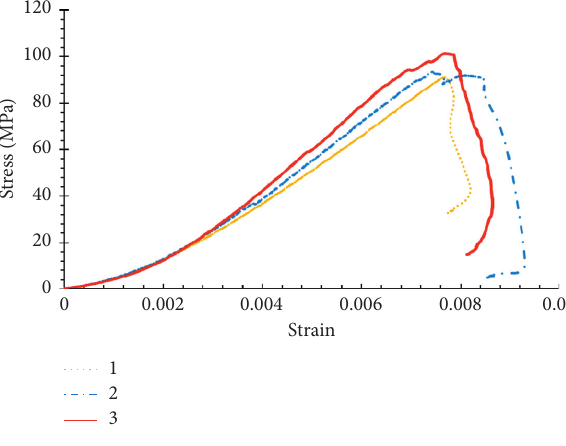
Figure 4: Stress-strain curve. Table 1: Rock mechanics